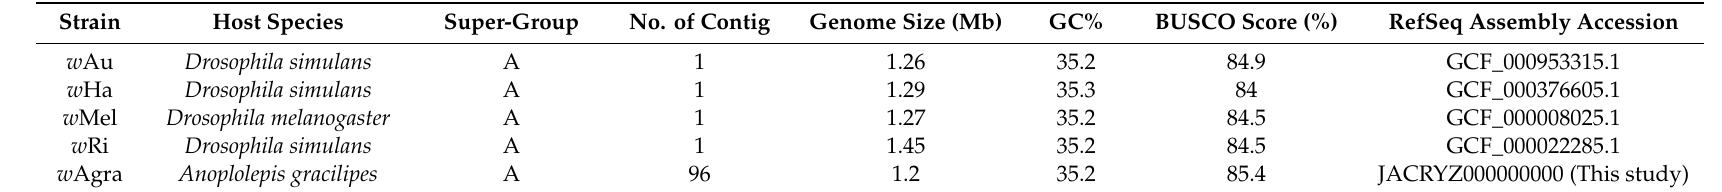
Table 2. Statistics of Wolbachia genome